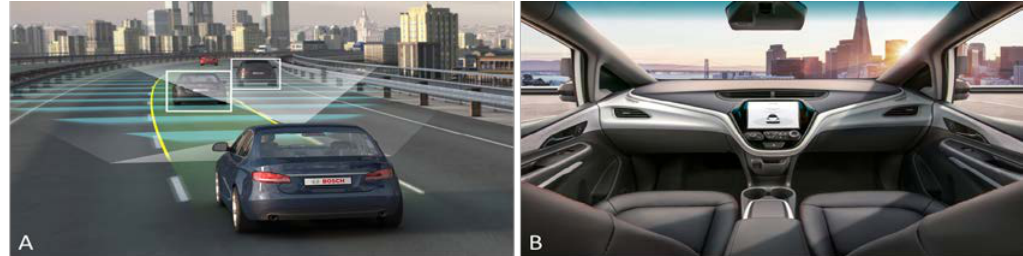
Figure 1. Artist’s vision of autonomous driven car. ( A ) GPS, guidance systems and sensor networks are Integrated to provide a smooth and uneventful trip. ( B ) These cars will have the same comfort features that current drivers are accustomed to having.